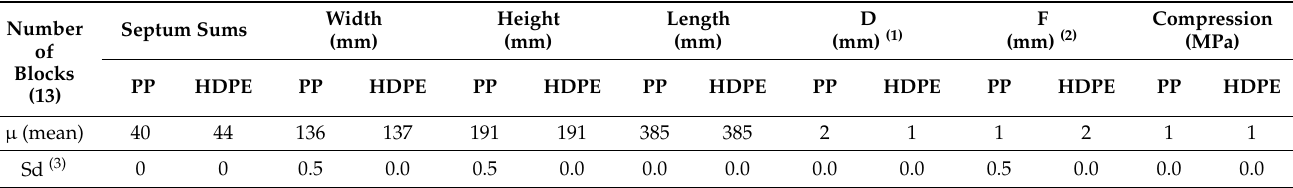
Table 2. Compressive